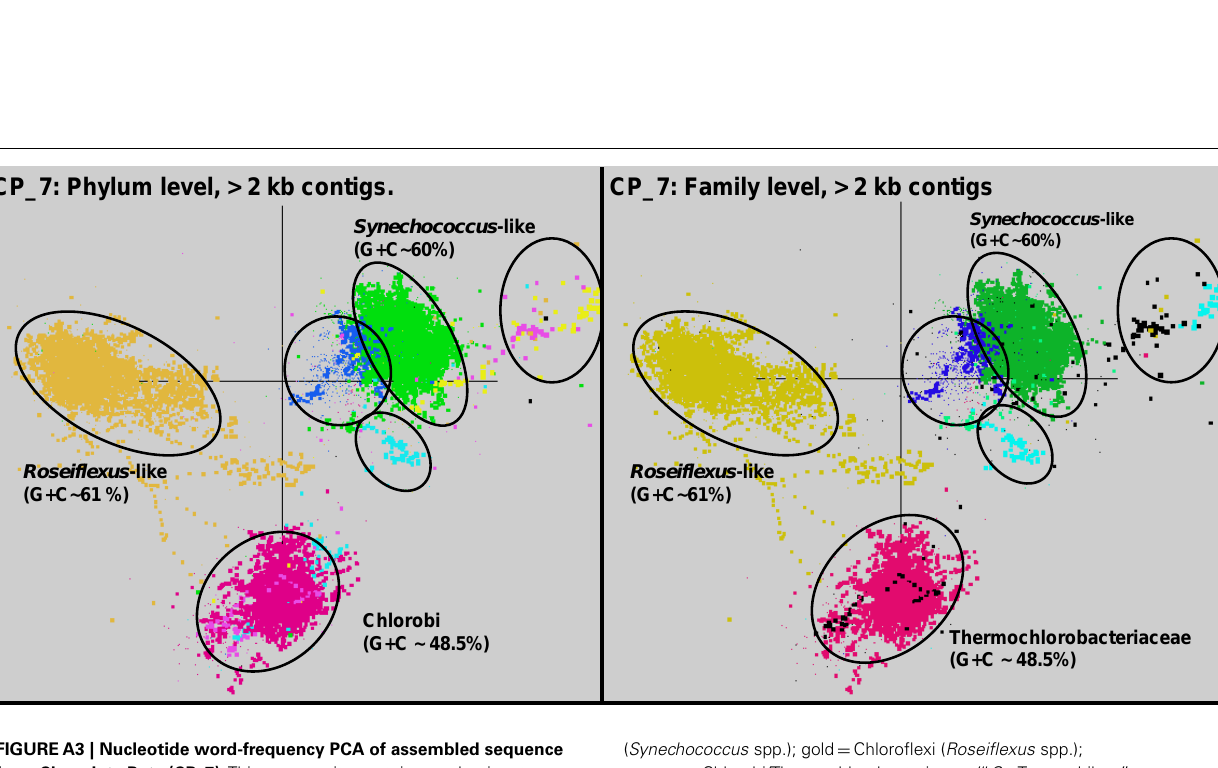
( Synechococcus spp.); gold = Chloroflexi ( Roseiflexus spp.); maroon = Chlorobi/Thermochlorobacteriaceae/“ Ca .T. aerophilum”, dark-blue = Spirochetes/ Leptospiraceae ; light-blue = Bacteroidetes/ Flexibacteraceae ; yellow = Firmicutes; light-purple =